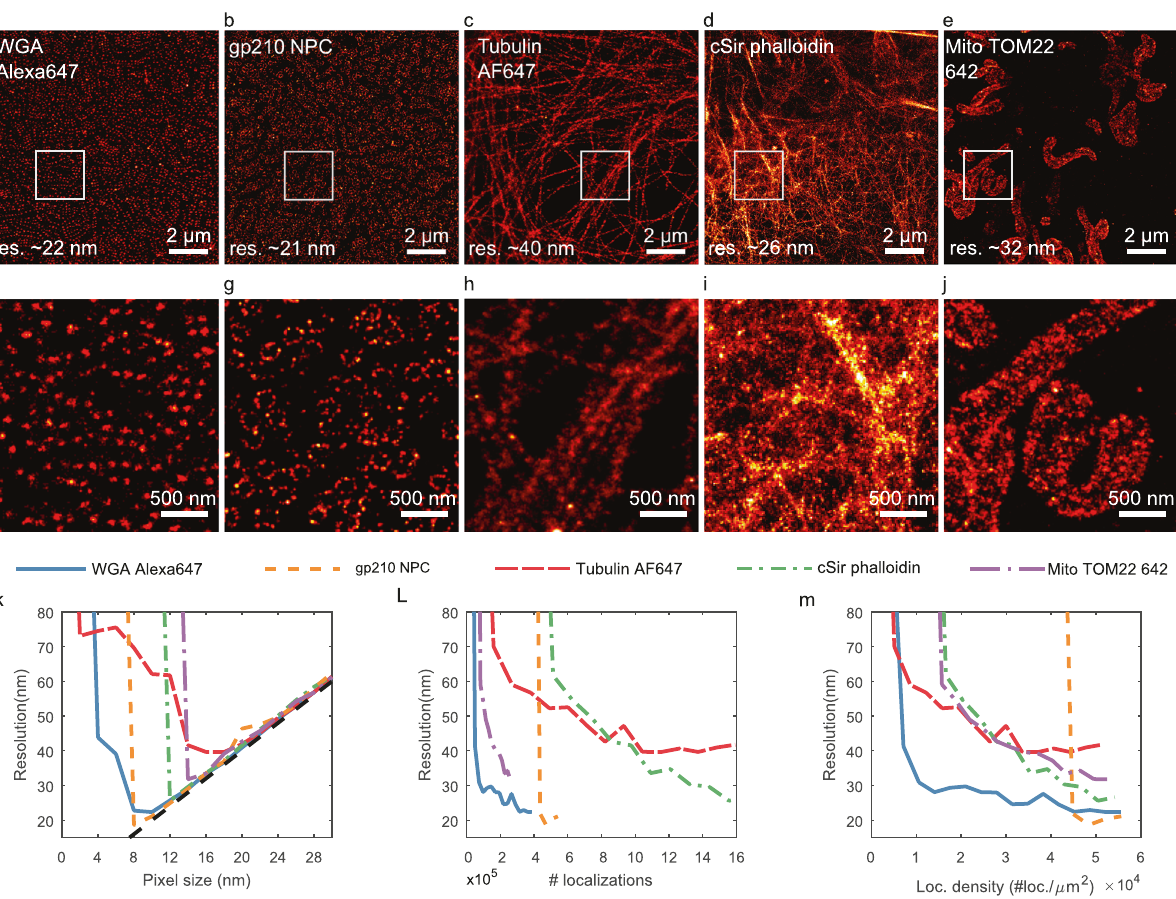
Fig. 2 Experimental resolution estimate using bilinear histogram rendering. a – e Selection of Shareloc.xyz data rendered with a pixel size of 5 nm ( fi eld- of-view of 12 × 12 µ m 2 ), scale bar: 2 µ m. The resolution indicated corresponds to the smallest resolution estimated from all the tested pixel sizes. f – j Zoom- in of a – e of 2.5 × 2.5 µ m 2 regions indicated by the white squares, scale bar: 500 nm. k Resolution vs pixel size. l Resolution as a function of number of localizations. m Resolution as a function of localization